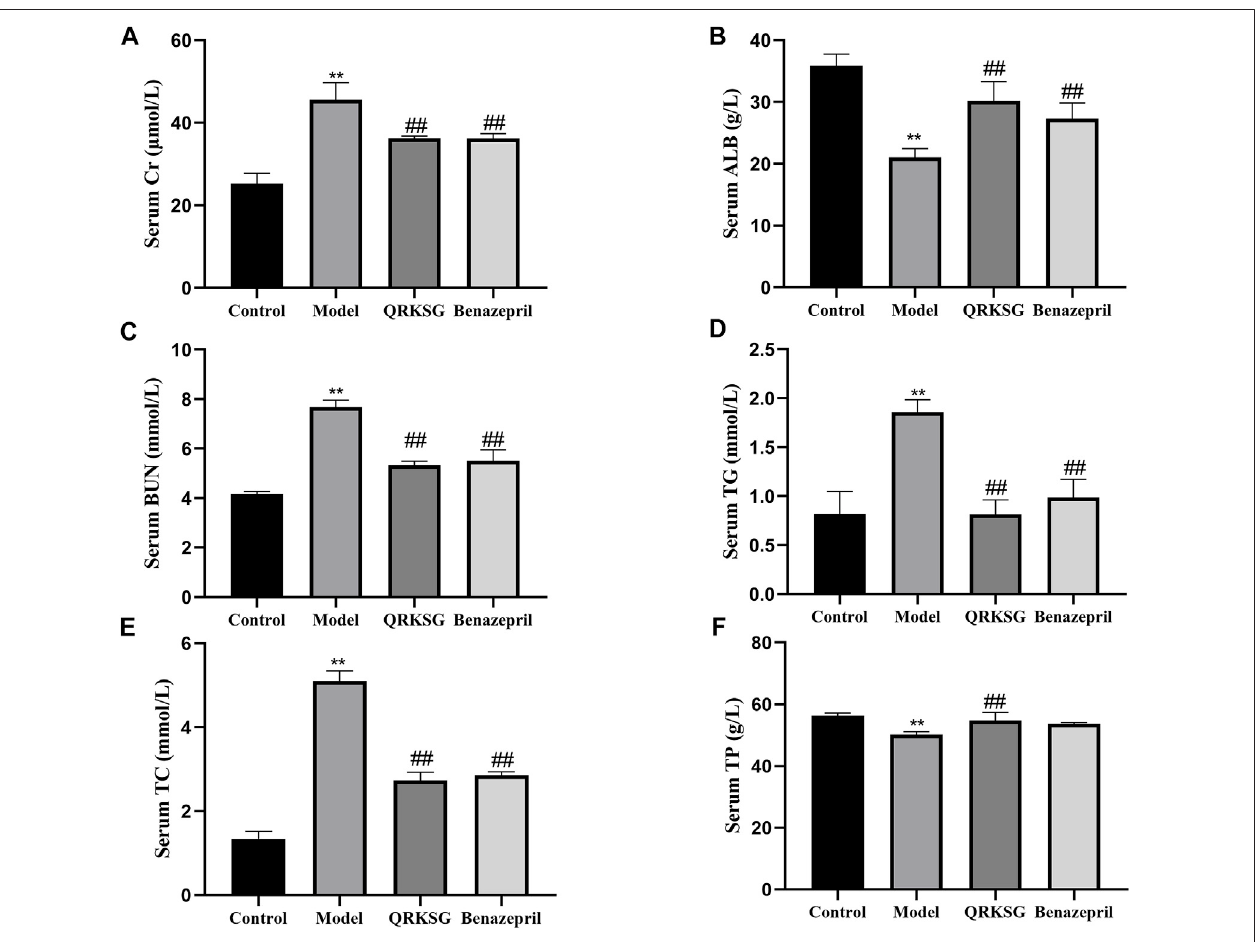
FIGURE 2 | Changes in serum biochemical parameters. (A) Serum Cr level (B) Serum ALB level (C) Serum BUN level (D) Serum TG level (E) Serum TC level (F) Serum TP level. The data are presented as mean ± SD, ** p < 0.05 shows comparison against the control group, and ## p < 0.05, against the model group.